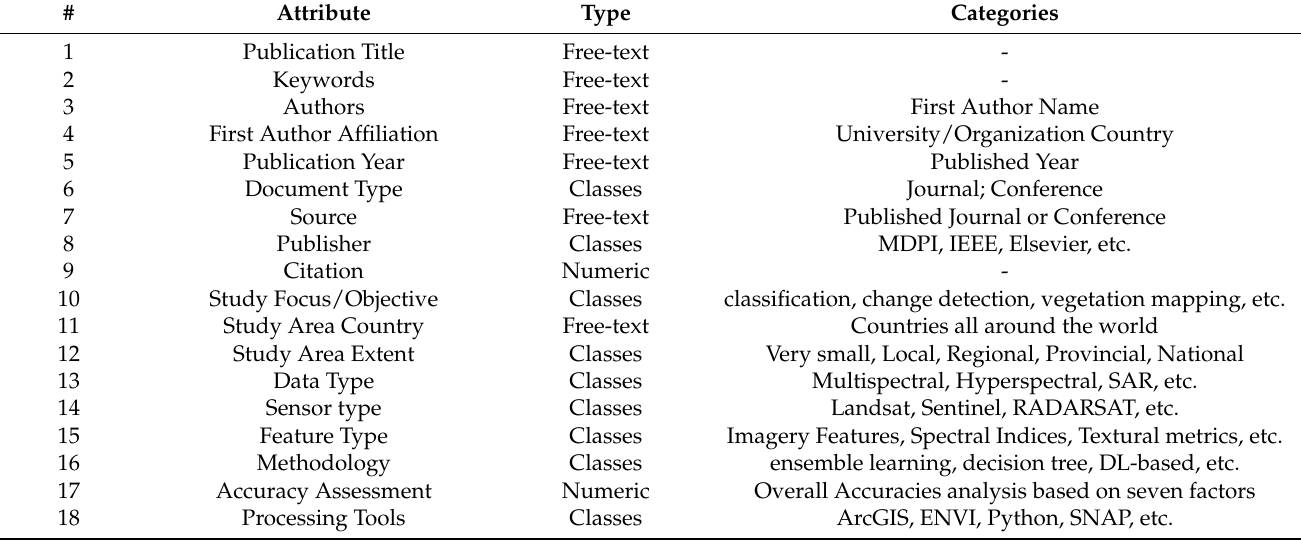
Table 2. A listing of extracted sub-fields/attributes considered for the content analysis of included papers.